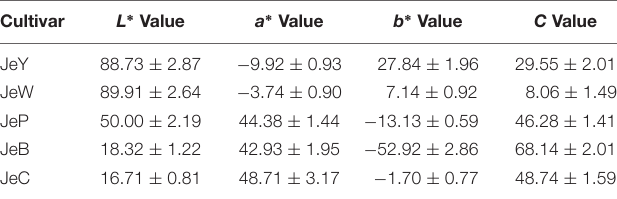
TABLE 1 | Flower color L ∗ , a ∗ , b ∗ and C values in middle petals of Senecio cruentus of five colors at full opening